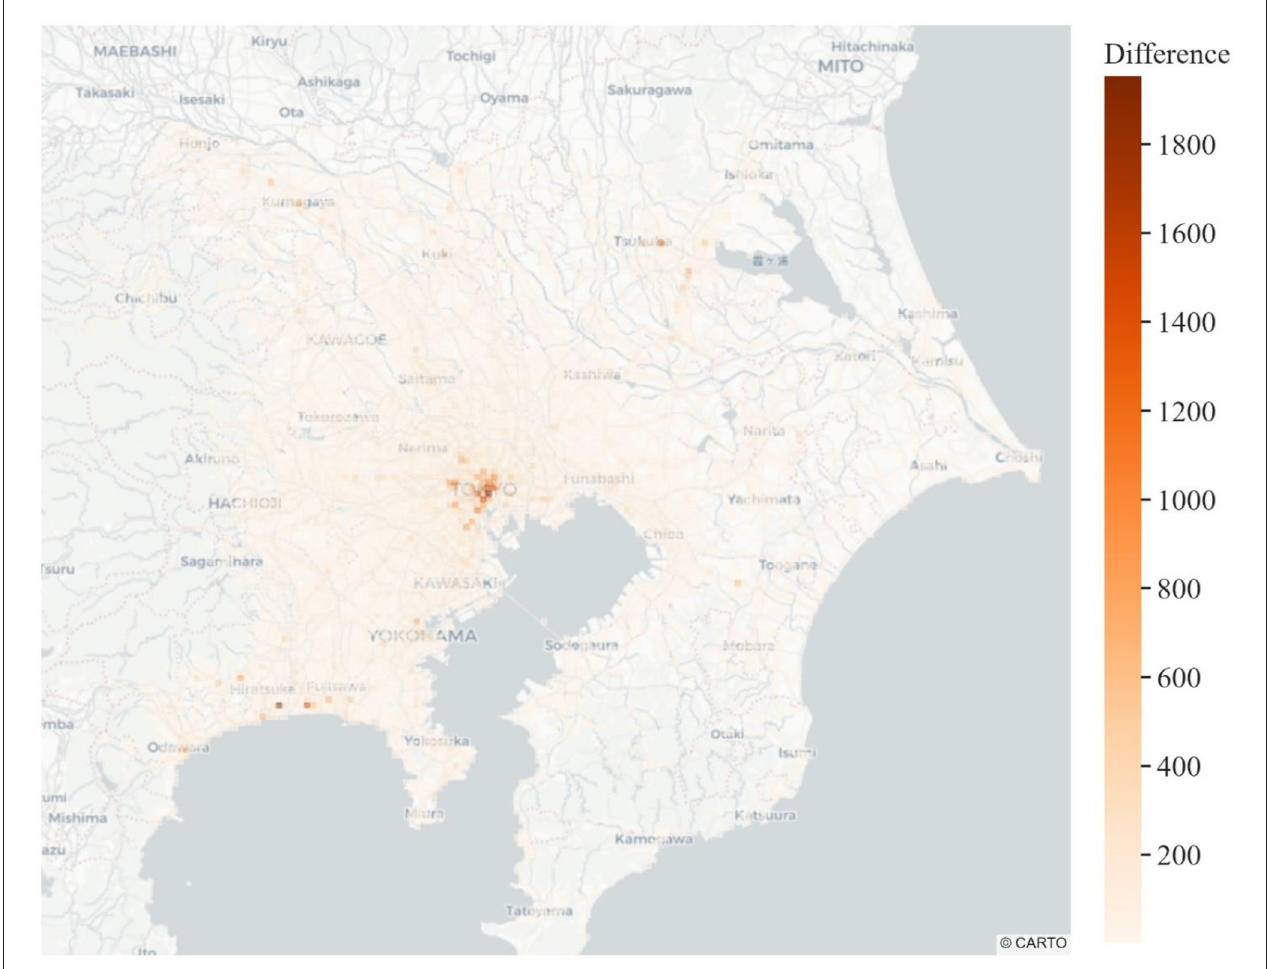
FIGURE 7 | Total trip origin difference between the observed and modeled origins–destinations